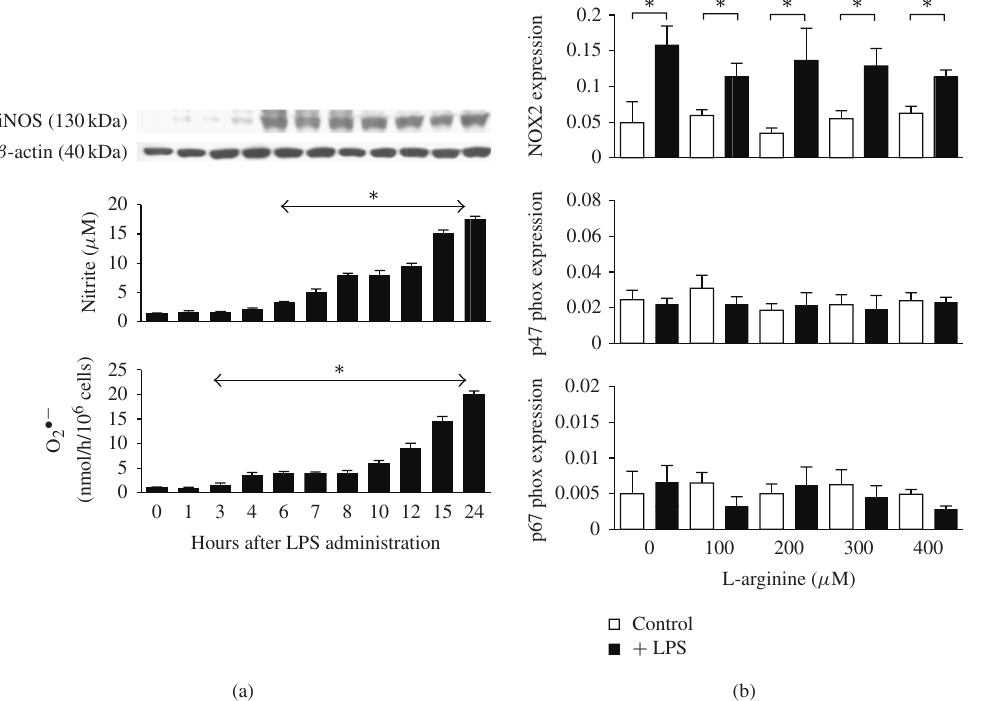
•− FIGURE 2: iNOS protein expression, nitrite accumulation, O 2 production and expression of mRNA for NOX2 in RAW 264.7 cells. Cells were incubated in the presence of DMEM media containing 400 μ M of L-arginine and stimulated with LPS (50 ng/mL). The expression of iNOS protein in cell lysates, the •− production in cell supernatants (a) were determined at the time points accumulation of nitrite, and the O 2 indicated. Results represent means ± SEM ( n = 6 ). (b) For NOX2, p47, and p67phox expression, cells were incubated in DMEM media with different concentrations of L-arginine (0, 100, 200, 300, and 400 μ M) and stimulated with LPS (50 ng/mL) for 4 h. Results represent means ± SEM ( n = 3 ). ∗ P < 0 . 05